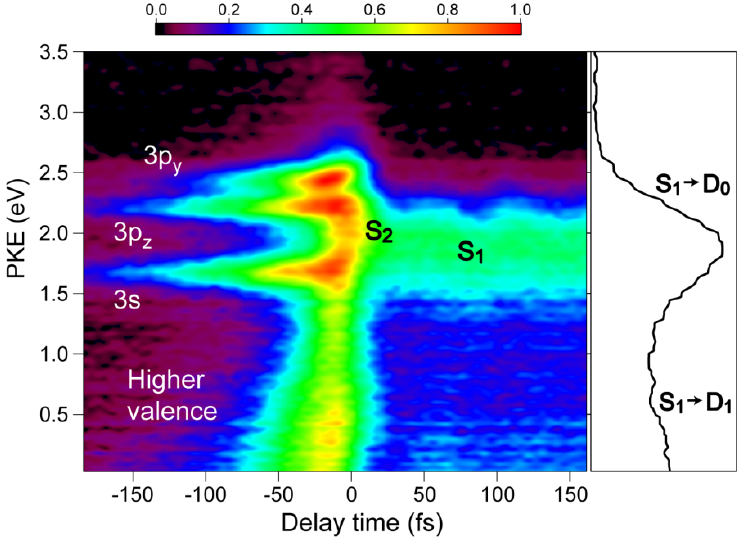
Figure 9. Photoelectron kinetic energy distribution observed for pyrazine using 264 nm pump and 159 nm probe pulses. Negative delay times indicate that the probe pulse precedes the pump pulse. The panel on the right shows the distribution integrated for the time delay of 50–150